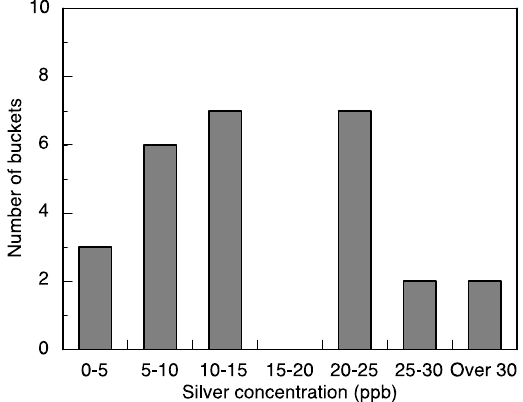
Figure 6. Histogram of the silver released in the buckets at the primary school in community A and laboratory tests of low-turbidity water ( n = 27). Total silver was measured by a graphite furnace atomic absorption spectrometer.